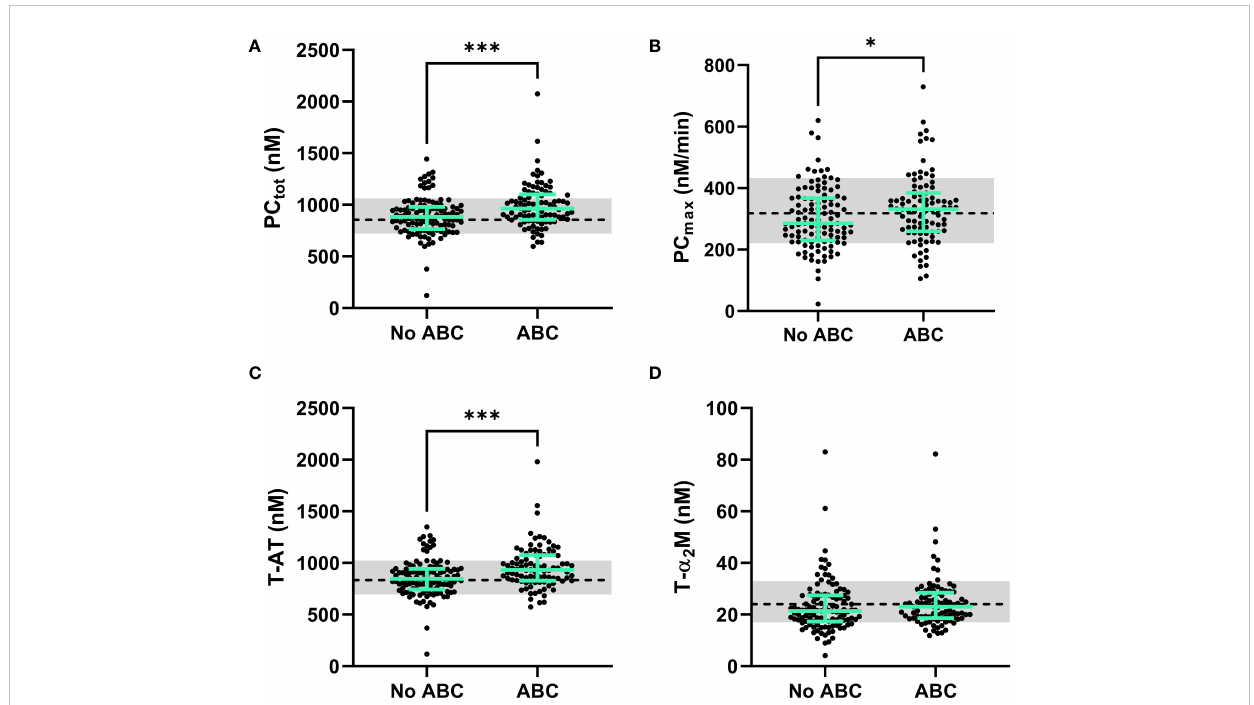
FIGURE 4 The dynamics of thrombin generation in PLHIV, strati fi ed for ABC treatment. (A) The total amount of prothrombin converted was signi fi cantly higher in PLHIV on ABC treatment compared to other treatment regimes. (B) The maximum rate of prothrombin activation by the prothrombinase complex showed signi fi cantly higher rates in ABC treated individuals. (C) Thrombin-antithrombin complex formation was signi fi cantly higher in ABC treated participants compared to participants on other treatment regimes. (D) Thrombin- a 2 -macroglobulin complex formation did not differ between ABC treated participants and participants on other treatment regimes. Data of PLHIV participants with and without ABC treatment are represented as dots with green bars indicating the group median and interquartile range. For comparison, the median of the controls without HIV is shown as a black dashed line and the interquartile range is depicted as a grey box. ***P<0.001 and *p<0.05 according to the Mann-Whitney test.